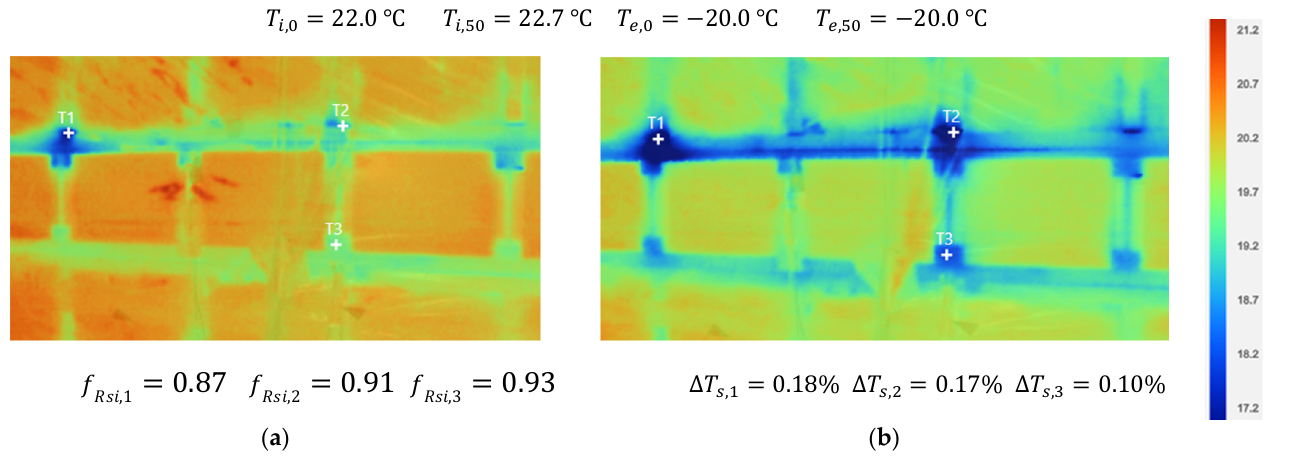
Figure 9. Thermographic analysis of the conventional wall at 0 Pa ( a ) and 50 Pa ( b ).